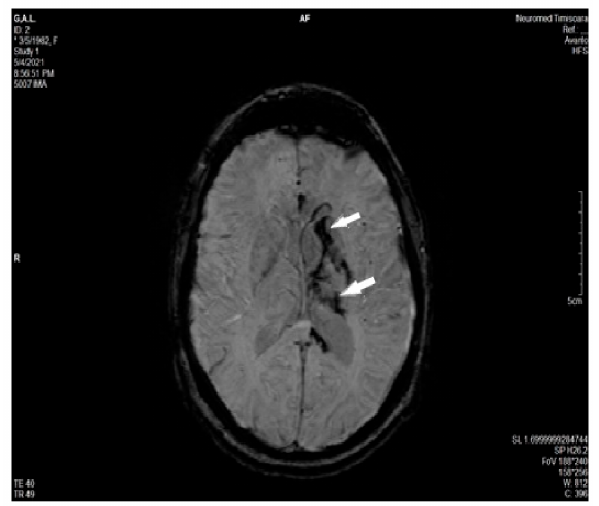
Figure 6. Axial SWI after 6 months demonstrates hemosiderin deposition in the chronic hemorrhagic area in the head and corpus of the left caudate nucleus and in the left thalamus